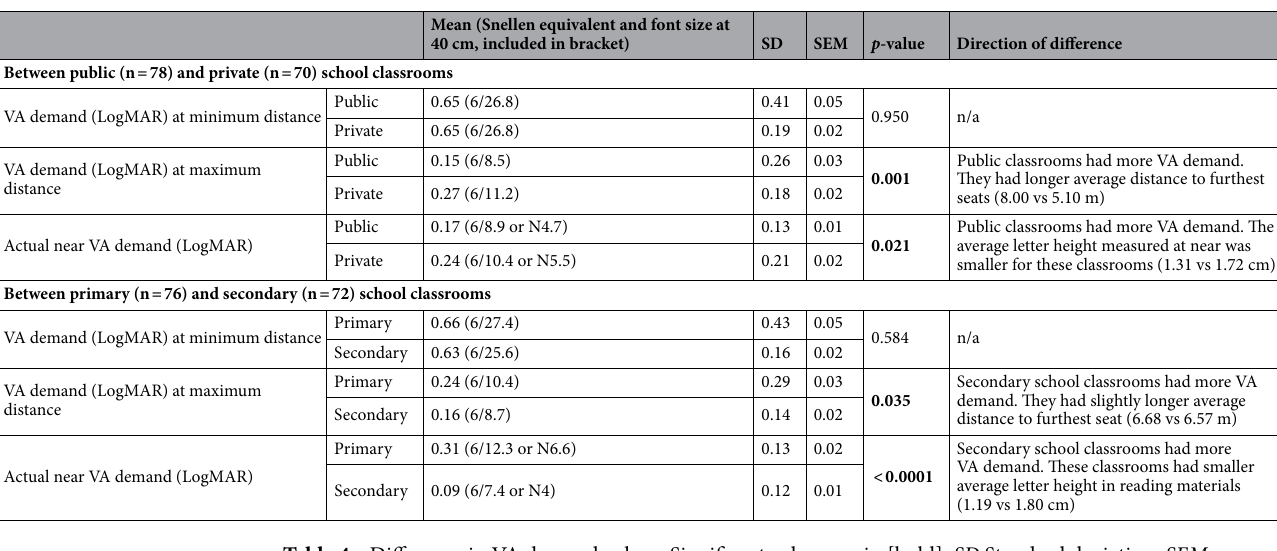
Table 4. Difference in VA demand values. Significant values are in [bold]. SD Standard deviation, SEM Standard error of mean.